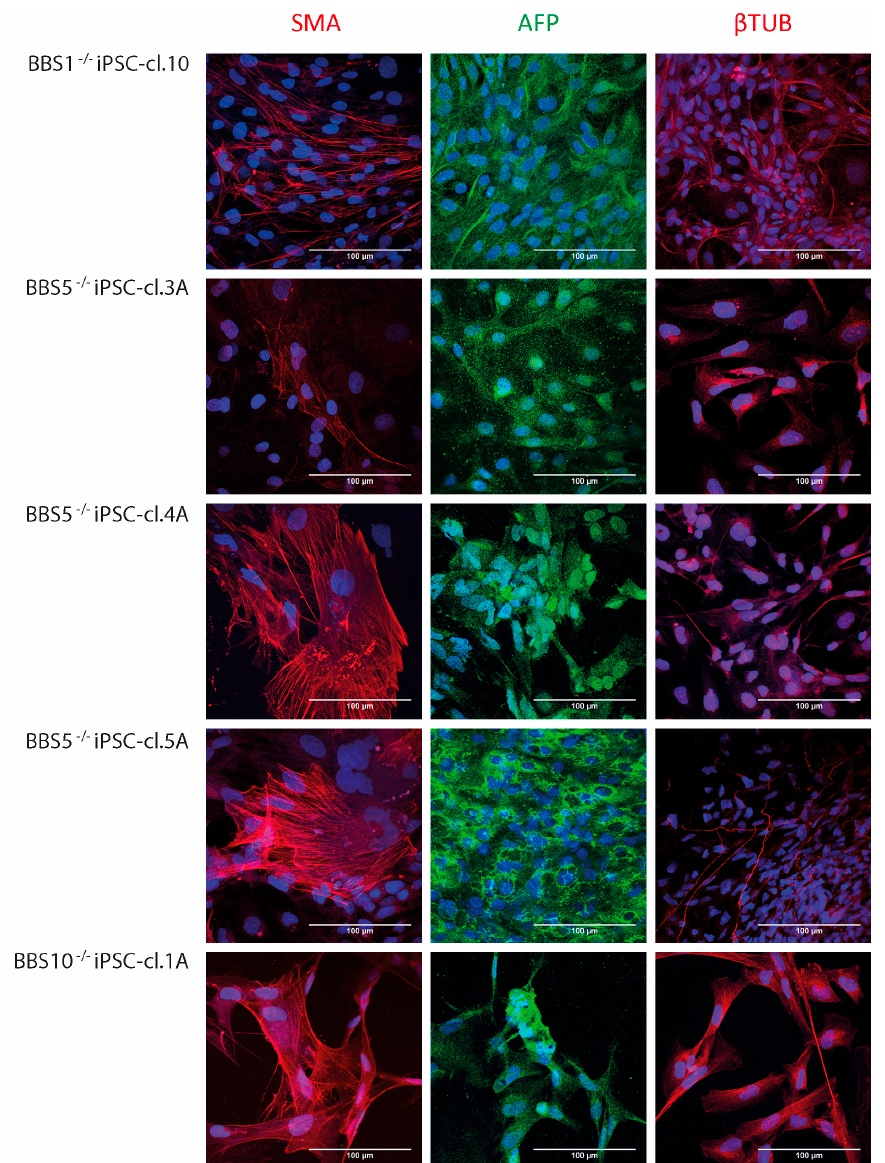
Figure 3. Immuno-fluorescence microscopy (IFM) analysis of BBS-induced pluripotent stem cells (iPSCs) after spontaneous differentiation towards the three germ layers. IFM performed after three weeks of spontaneous differentiation. The cells were labelled with anti- α -smooth muscle actin (SMA; mesoderm marker), anti- α -fetoprotein (AFP; endodermal marker) and anti- β III-tubulin ( β TUB; ectoderm marker). All the 5 different iPSC clones (BBS1 − / − iPSC-cl.10, BBS5 − / − iPSC-cl.3A, BBS5 − / − iPSC-cl.4A, BBS5 − / − iPSC-cl.5A and BBS10 − / − iPSC-cl.l1A) generated from BBS fibroblast were able to spontaneously differentiate into cells of all three germ layers (scalebar 100 µ m). To assess the maturation process of the generated RPE cells, gene expression of PAX6 (retinal precursor marker), BEST1 and RPE65 (both mature RPE markers) were investigated at different timepoints. mRNA was isolated at day 0 (iPSC), day 14 (d14) and at the end of each of the three subsequent passages: P0, P1 and P2 (Figure 4B). PAX6 expression declined after day 14 of RPE differentiation, whereas BEST1 and RPE65 expression increased over time and peaked at P2. A similar pattern was obtained for differentiation of K3 iPSC and BBS1 − / − iPSC